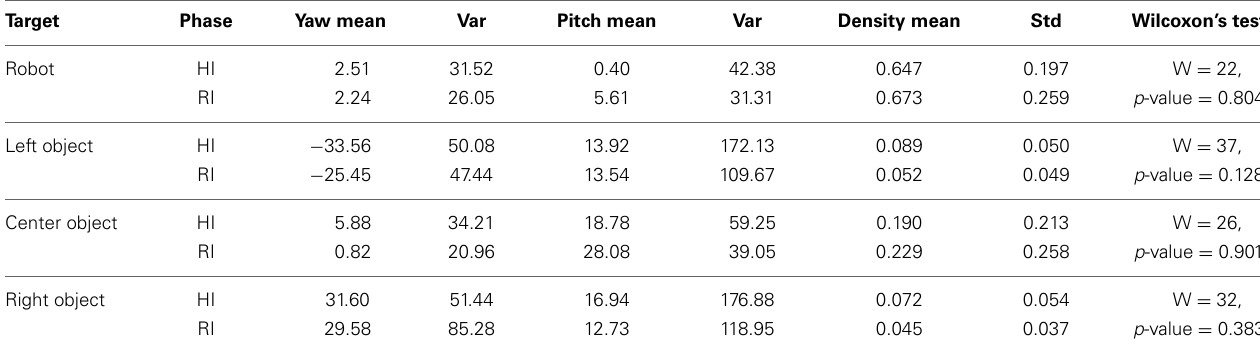
Table 3 | Characteristics of the four clusters of gaze points, corresponding to robot and objects, in the normalized head’s pitch-yaw space of the participants in HI and RI